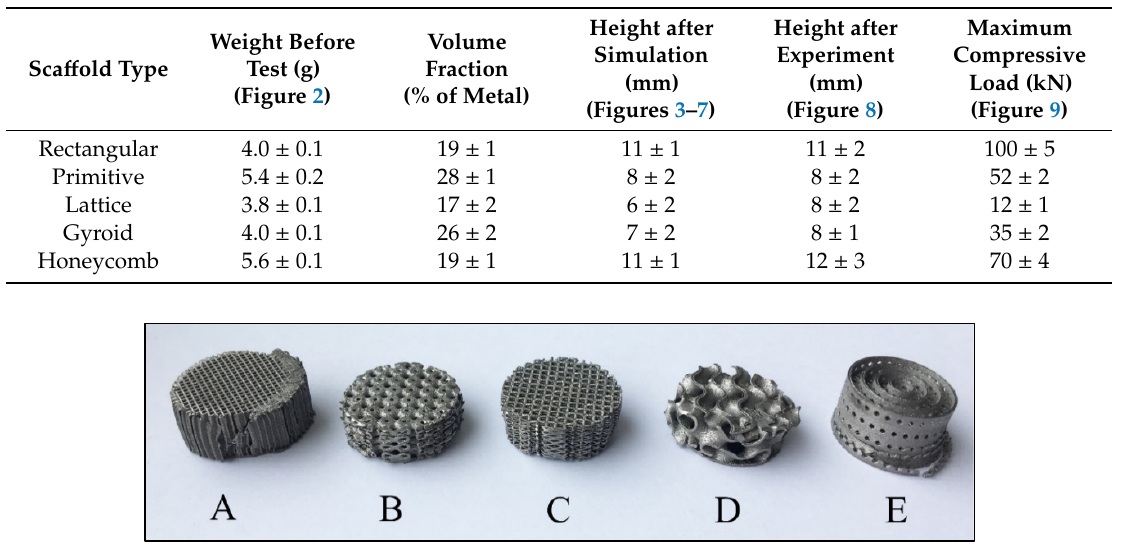
Table 1. Compression test data (comparison of finite element analysis (FEA) simulation and experimental results).